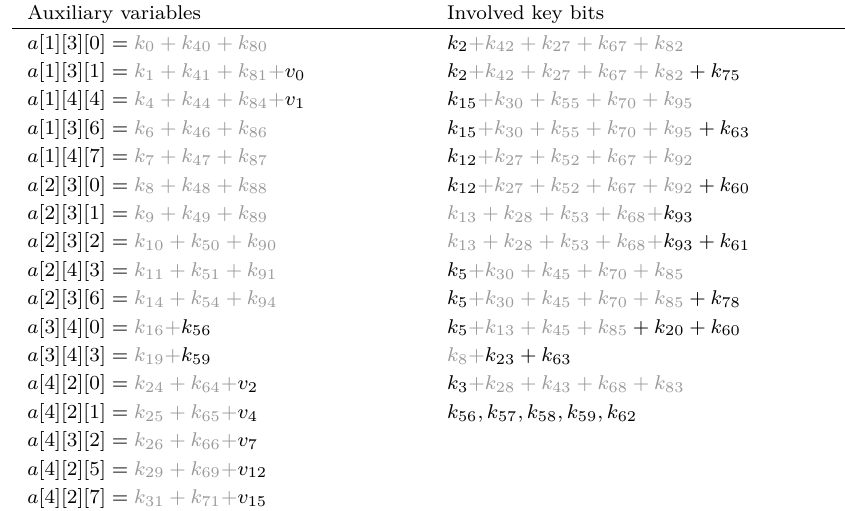
Table 5: Auxiliary variables and involved key bits of the first cube for Ketje Jr V1 where the gray key bits are set to be zero in the preprocessing